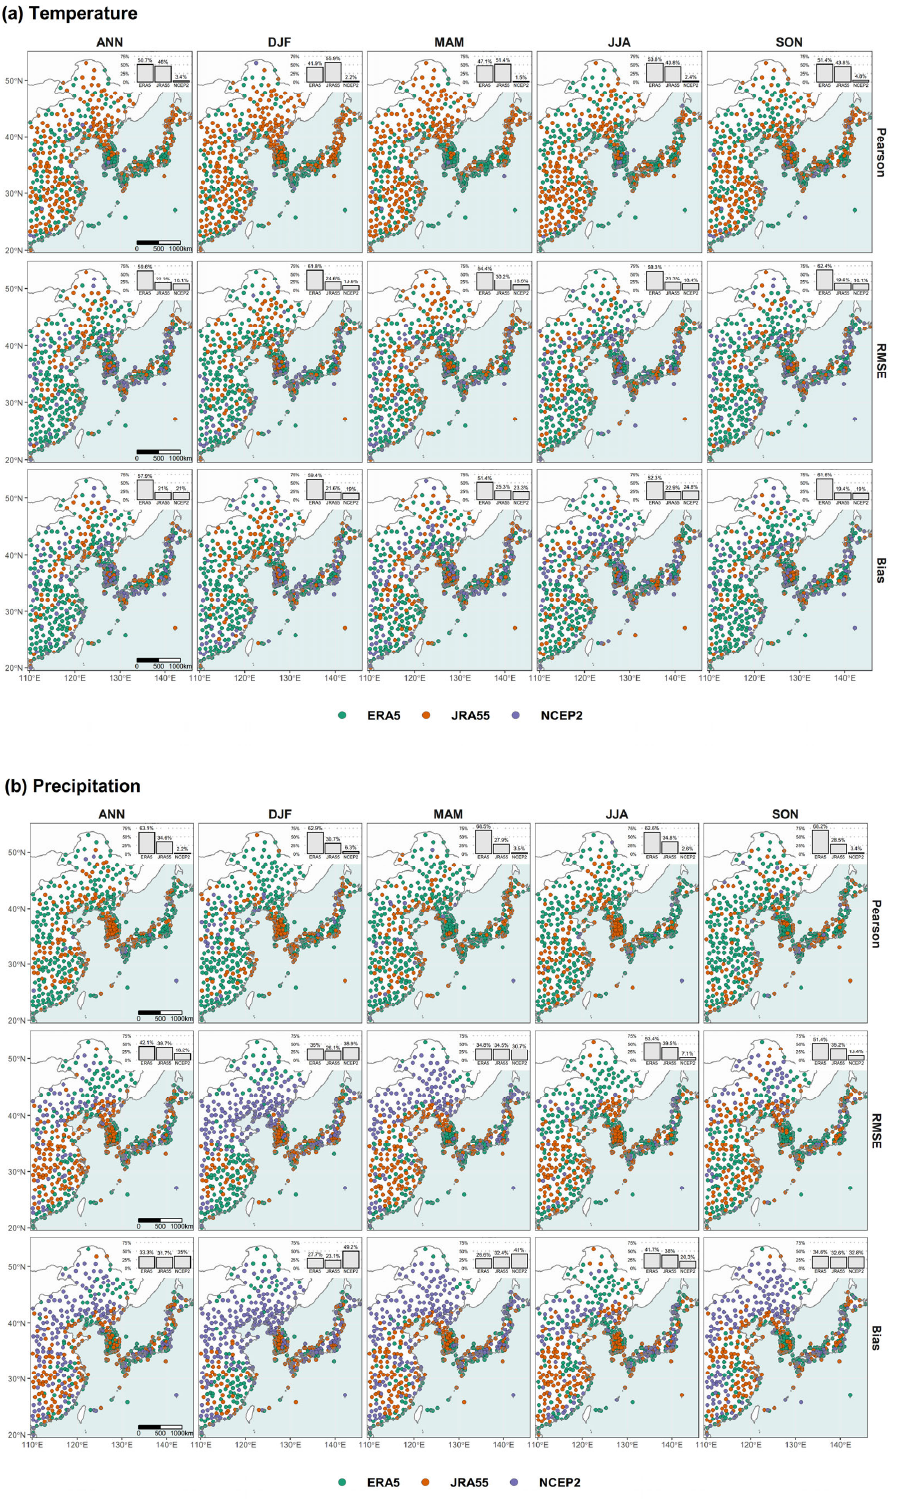
Figure 8. The selected best reanalysis data among ERA5, JRA55, and NCEP2 by stations of ( a ) tem- perature and ( b ) precipitation based on Pearson correlation coefficients, bias, and RMSE in the EAM region for annual and seasonal means during the forty years of 1981–2020 for North Korea, South Korea, and Japan and the thirty years of 1981–2010 for China. Histograms at the upper-right corner of map indicate the number of stations selected as the best